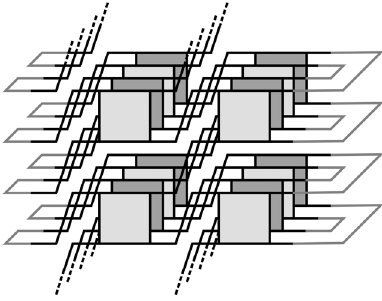
FIG. 23. Diagram of Z 2 ðþ ; − ; t Þ , where we force a domain wall into the pairings of copies of orbits. The different circuit layers here correspond to forward (light) and backward (dark)